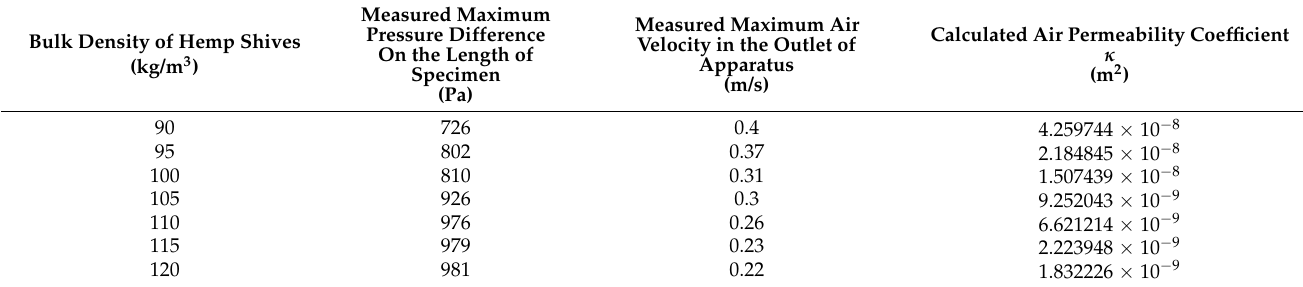
Table 3. Results of the air permeability for investigated densities of hemp